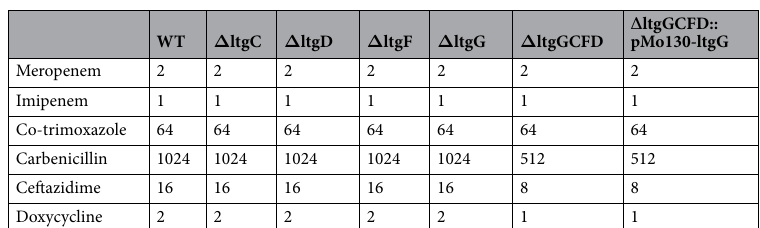
Table 2. Minimum inhibitory concentrations of Ltg mutants of B. pseudomallei for selected antimicrobial agents. Antibiotic susceptibility was measured by determining the MIC by serial dilution method. Results are from triplicate experiments (four replicate wells per experiment). Concentrations are in µ g/ml. WT – wildtype